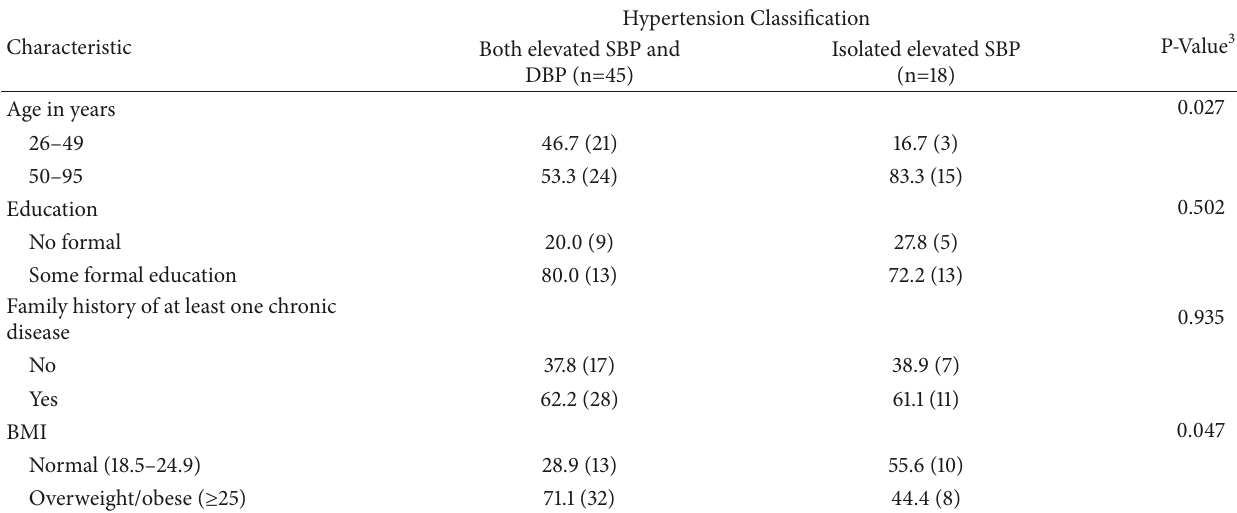
and DBP 2 and those with only elevated SBP.